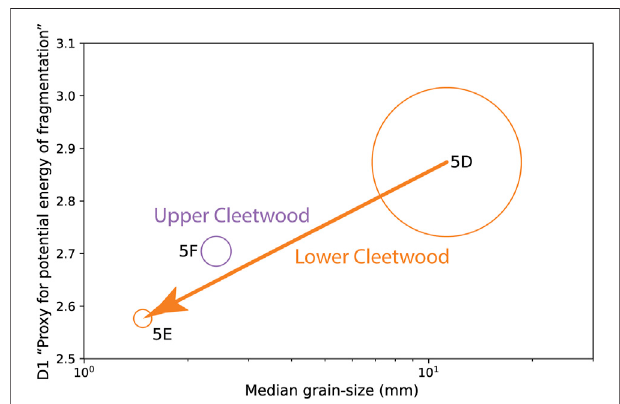
FIGURE 12 | D1 values (i.e., fractal dimension of the cumulative size distribution of particles < 0.125 mm) found for all subunits of Cltwd 5, plotted as a function of the median grain-size of that subunit. Circle size is representative of the inferred plume height and thus mass eruption rate (MER), being the lowest for Llao Rock, highest but continuously decreasing (from 5D to 5E) for lower Cleetwood, and intermediate for upper Cleetwood.